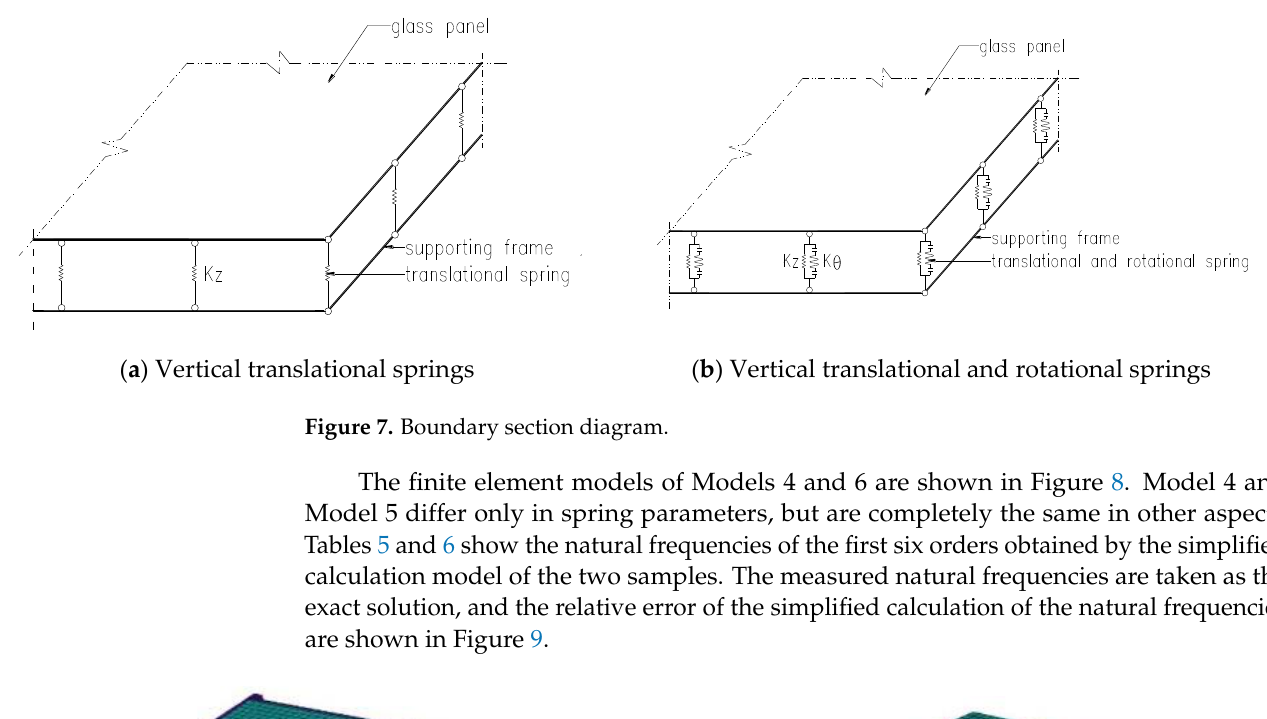
Figure 7. Boundary section diagram.